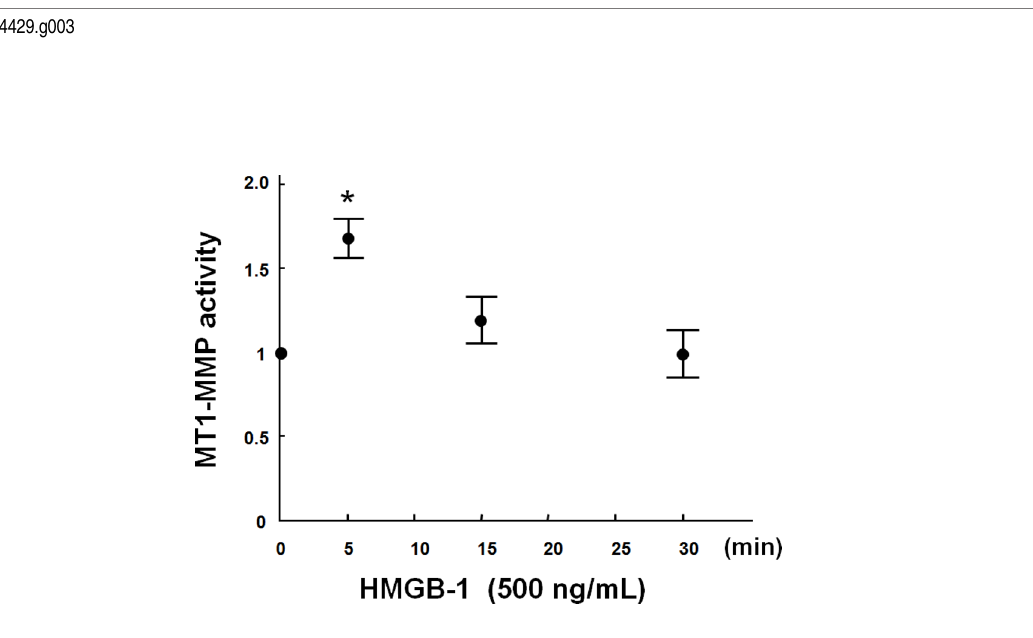
Fig. 4. HMGB-1 increases MT1-MMP activity in cultured endothelial cells. Plasma membrane fractions were extracted from HAECs. Changes in the activity of MT1-MMP are shown after HMGB-1 stimulation. Results are expressed as mean ¡ S.D. of 3 separate experiments performed in pentaplicate. * P , 0.05 vs. 0 minute before HMGB-1